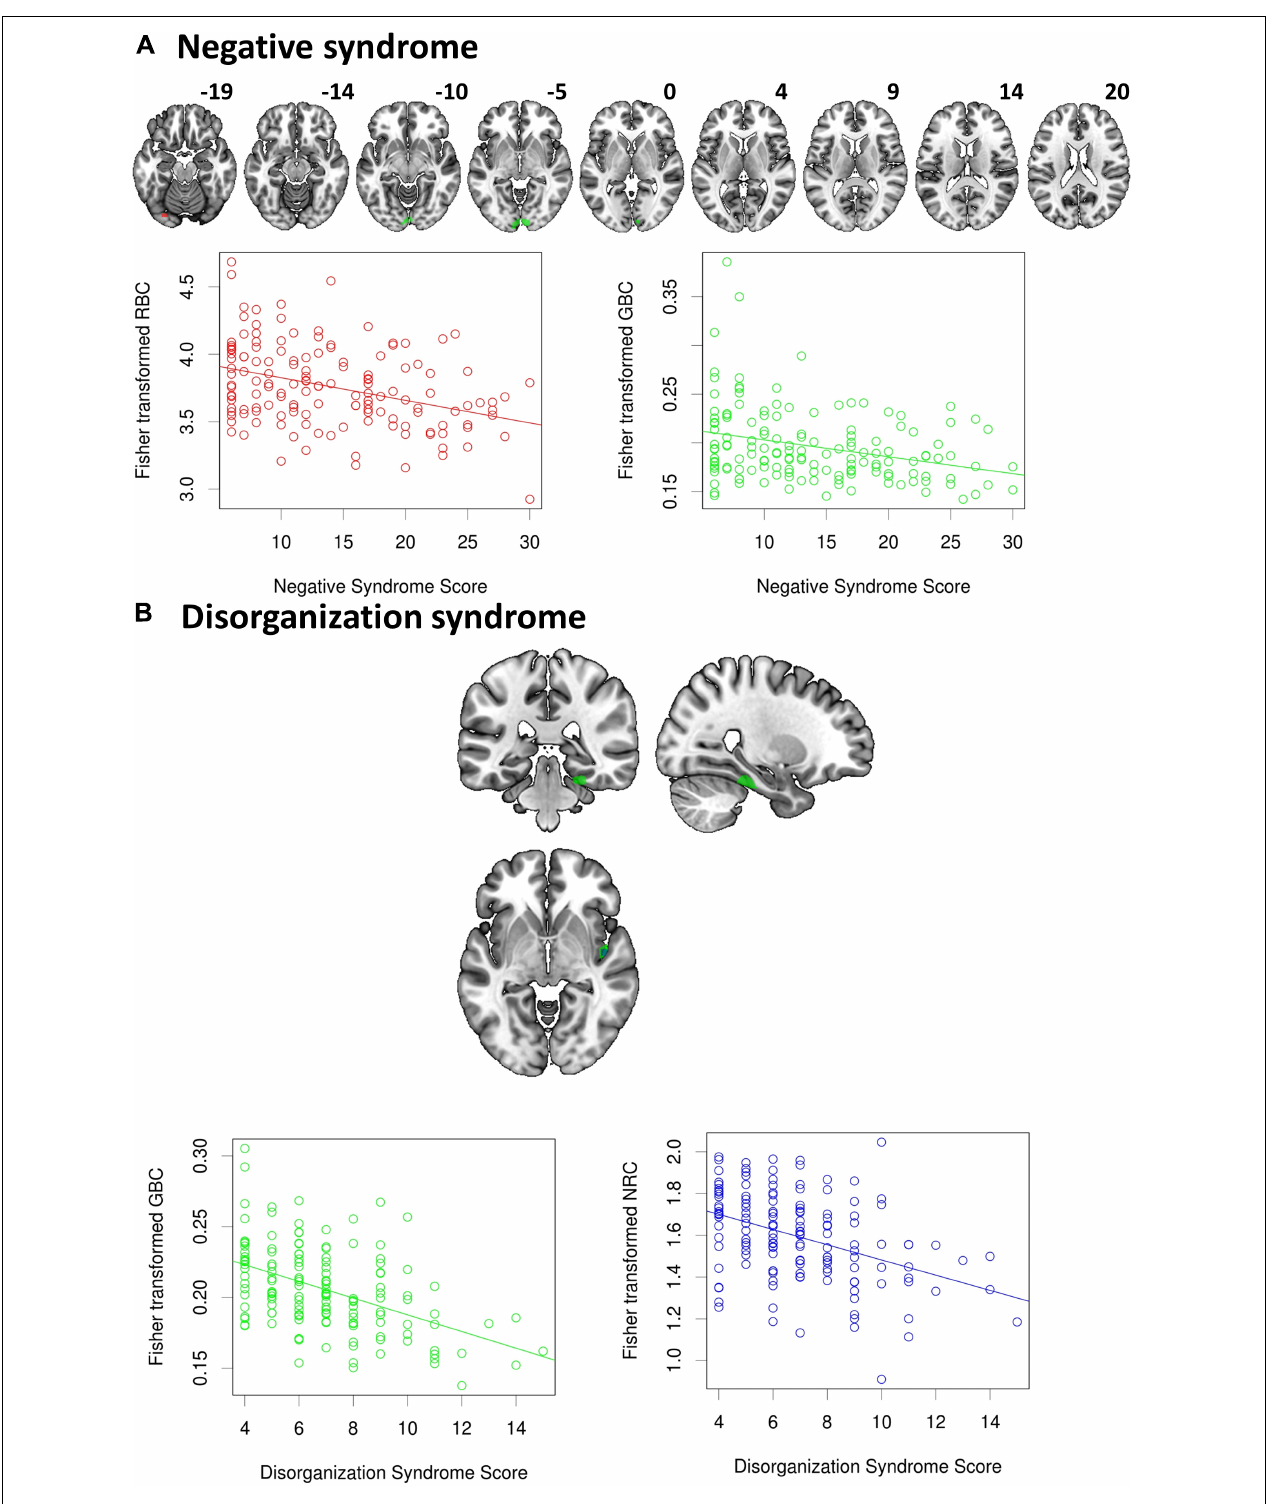
FIGURE 3 | Significant associations between scores from the Liddle syndromes and connectivity levels. While (A) a negative relation was observed between the Negative syndrome and both the RBC and GBC in occipital areas, (B) the Disorganization syndrome was negatively correlated with the GBC and the NRC, but the latter only involved a very small cluster located in the right posterior insula. No association was found with positive syndrome scores.